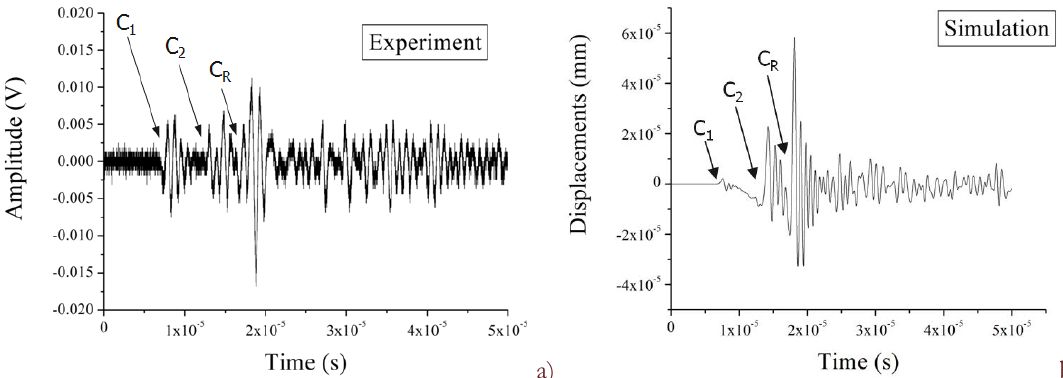
Figura 8: a) Tensione elettrica, proporzionale agli spostamenti superficiali, in funzione del tempo per il trasduttore posizionato sopra il fungo; b) spostamenti normali alla superficie misurati con l’approccio numerico nello stesso punto.